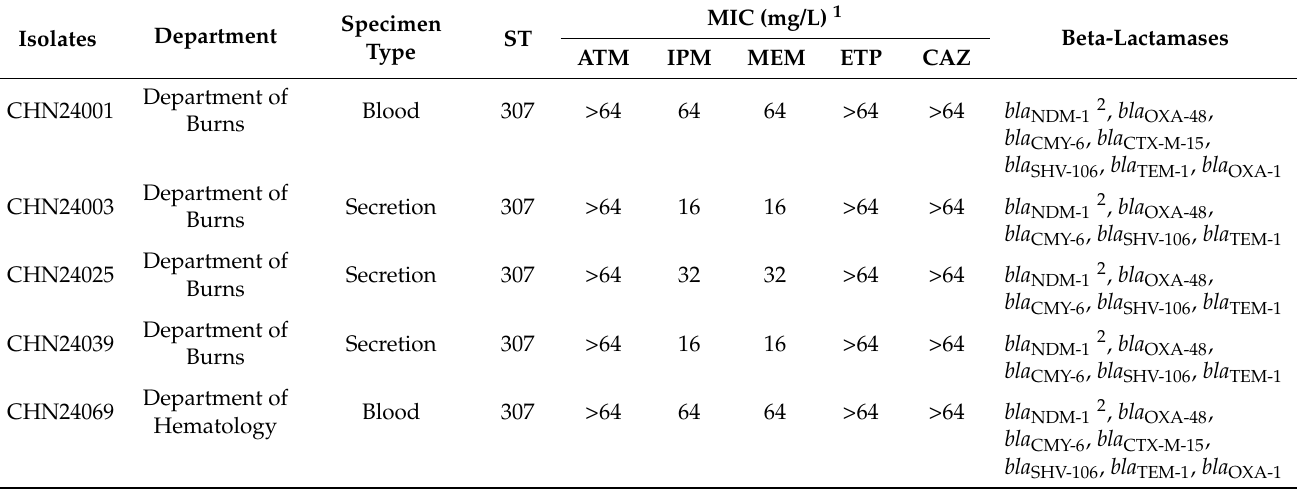
Table 1. The department, specimen type, ST, antimicrobial susceptibility, and beta-lactam resistance genes of K. pneumoniae .